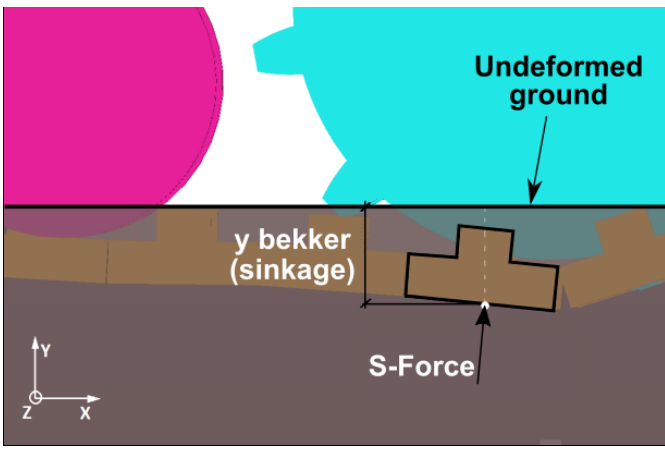
Figure 8. Bekker force acting on a single-track link.